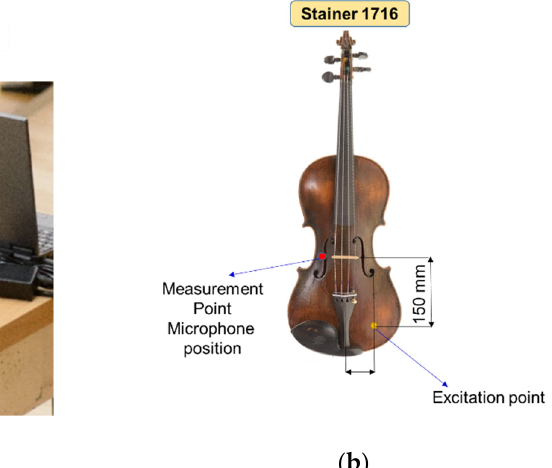
Figure 3. How to measure ring rings for the top plates/back plates of violins—case study of the Stradivarius Elder Voicu 1702 (photo courtesy of the “George Enescu” Bucharest Philharmonic and master violinist Tomescu Alexandru): ( a ) measuring the series of annual rings on the top plate; ( b ) measuring the wavelength of the curly fiber of maple from the back plate.